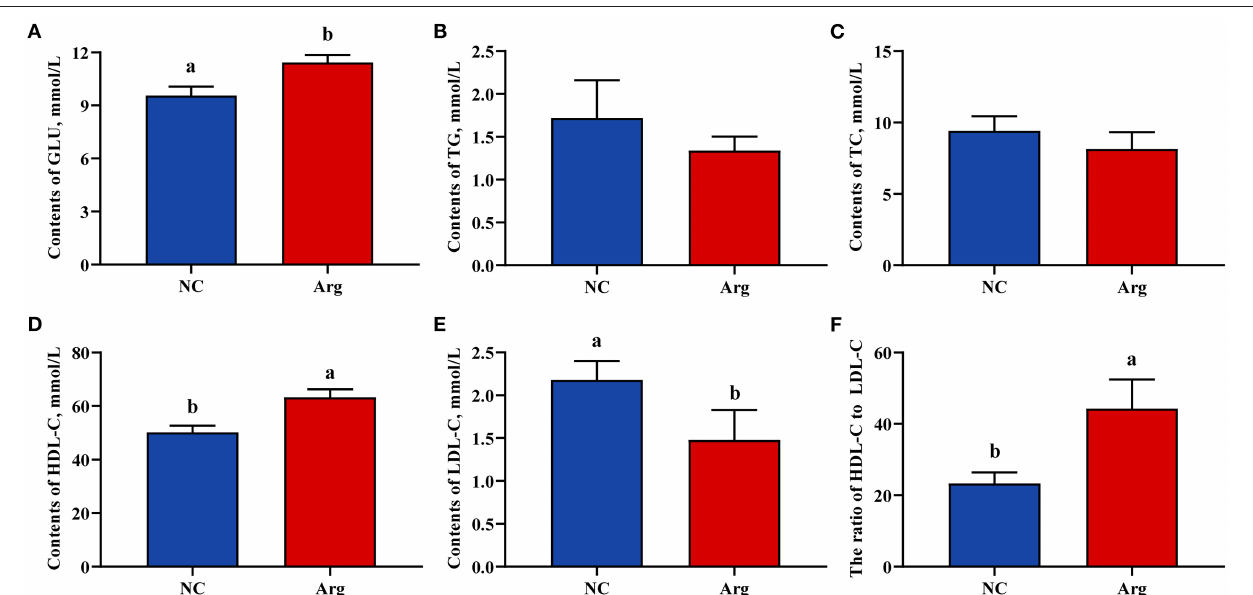
FIGURE 2 | Effects of in ovo feeding of L -arginine on the serum biochemical parameters at the age of embryos 21. (A) Glucose contents; (B) Triglycerides contents; (C) Total cholesterol contents; (D) High-density lipoprotein cholesterol contents; (E) Low-density lipoprotein cholesterol contents; (F) The ratio of high-density lipoprotein cholesterol to low-density lipoprotein cholesterol; a,b Values at the same index with no common superscripts differ significantly ( p < 0.05). NC, non-injected control group; Arg, in ovo of feeding of 7mg L -arginine group; GLU, glucose; TG, triglycerides; TC, total cholesterol; HDL-C, high-density lipoprotein cholesterol; LDL-C, low-density lipoprotein